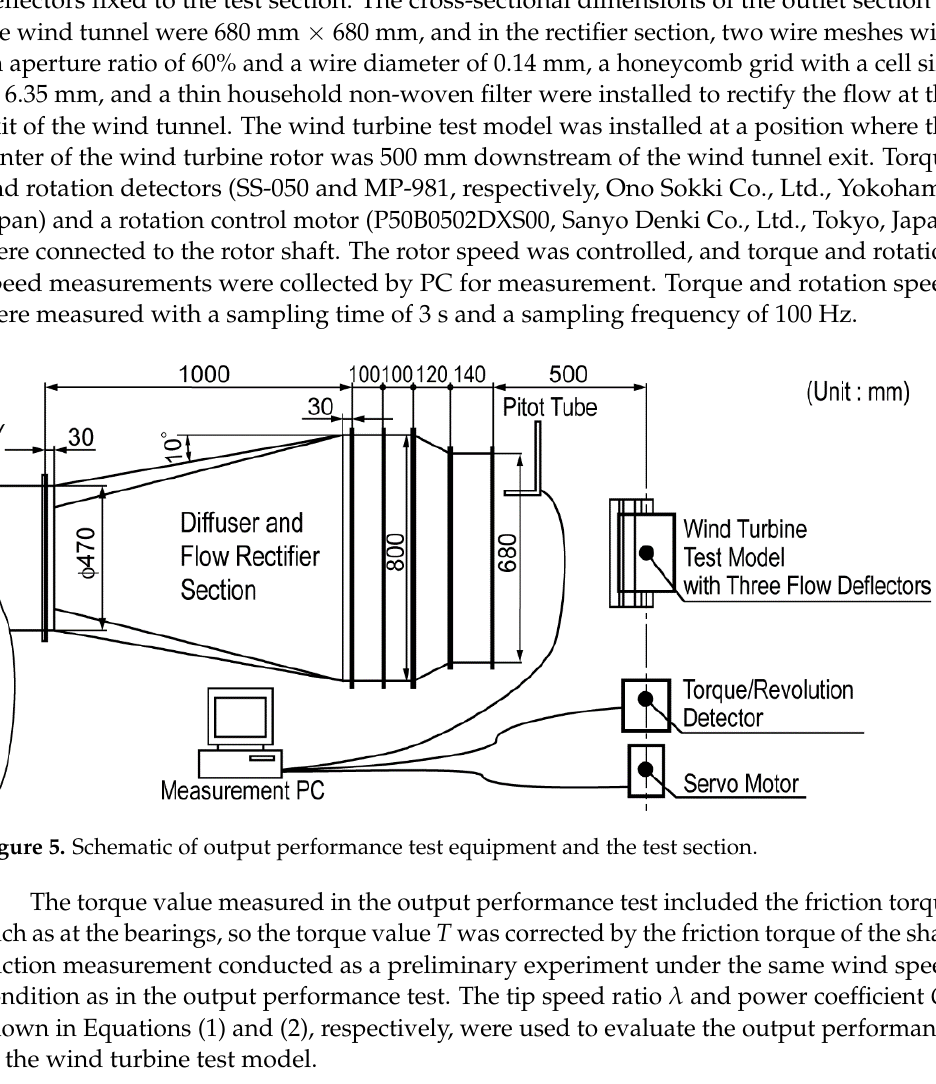
Table 1. Conditions of inlet wind speed and inclination angles of wind-collecting casing for output performance test experiment and numerical flow simulation.